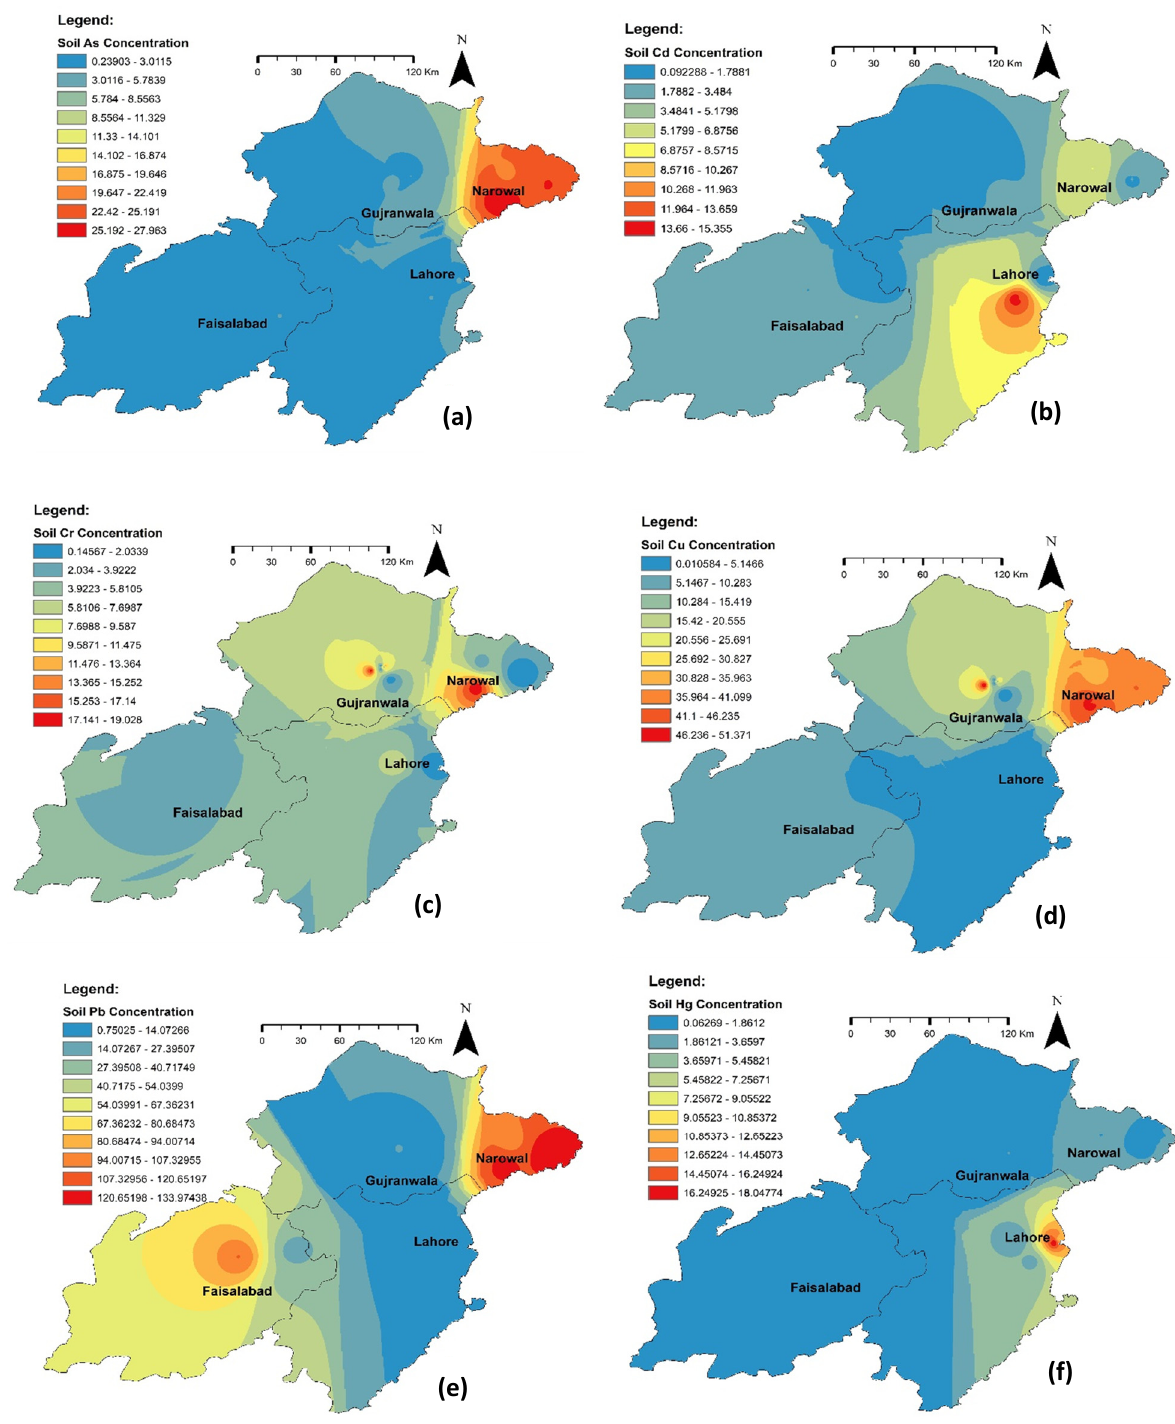
Figure 4. Spatial distribution maps of various metal and metalloid concentrations in surface soil samples. Variation in color indicates the levels of metals and metalloid (mg kg − 1 ) concentrations in soil samples from sampling points; ( a ) arsenic contents; ( b ) cadmium contents; ( c ) chromium contents; ( d ) copper contents; ( e ) lead contents; ( f ) mercury contents. The average concentrations (mg kg − 1 ) of Pb (2.85) and Cu (1.71) in the soil samples of